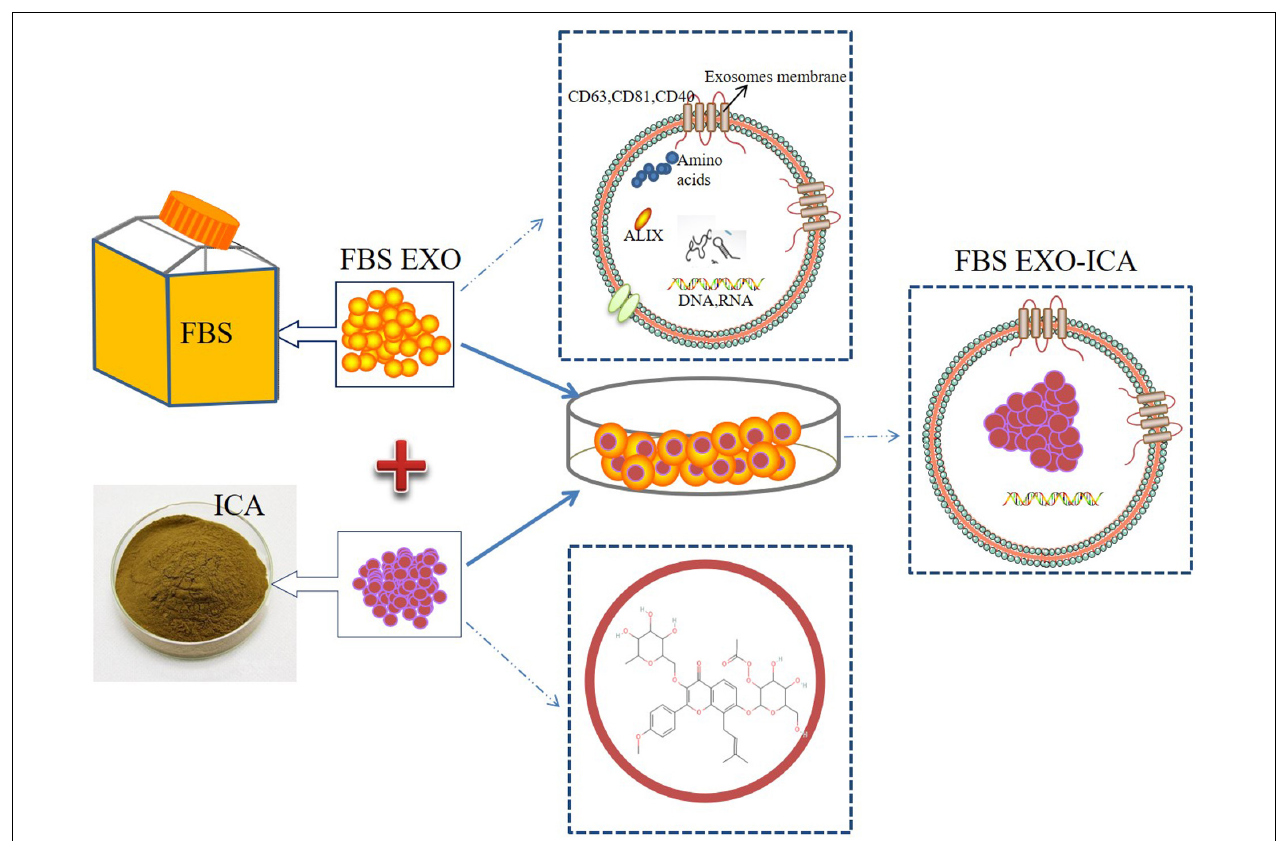
FIGURE 1 | Schematic illustration of construction FBS